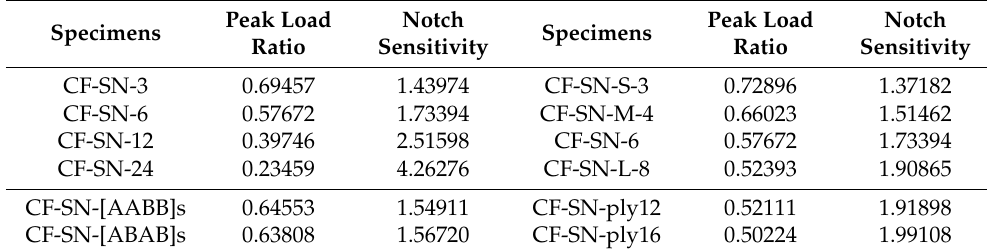
Table 2. Tensile strength ratios and notch